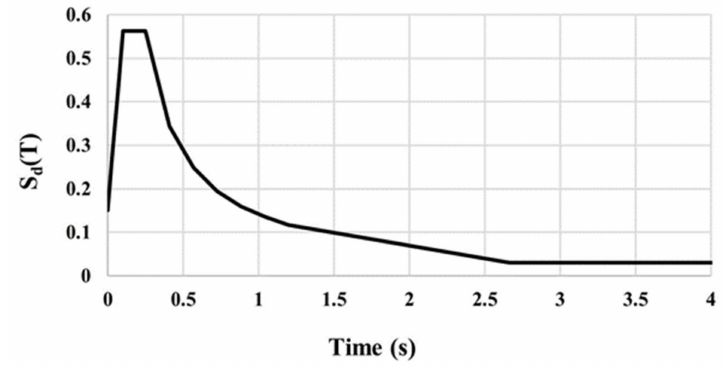
Figure 1. Elastic-design response